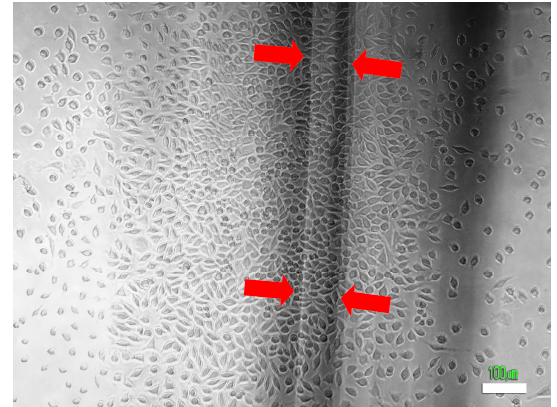
Figure 7. Photomicrograph showing the view of the bottom of the culture chamber with L929 mouse fibroblasts two days after irradiation with RL light ( λ = 650 nm) from SGF 5 . The arrows demarcate the position of the fiber above the plane of the cells. It can be observed that the cell density is higher below the fiber than on the rest of the culture surface. (Scale bar is 100 µm).